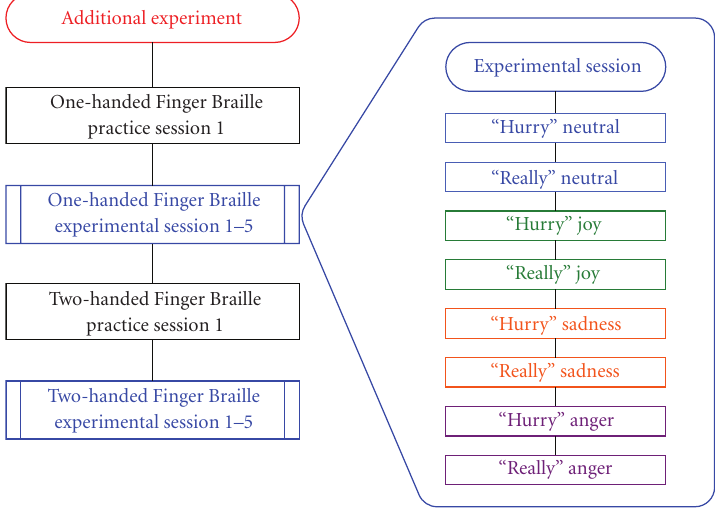
Figure 12: Flow of addition to Experiment